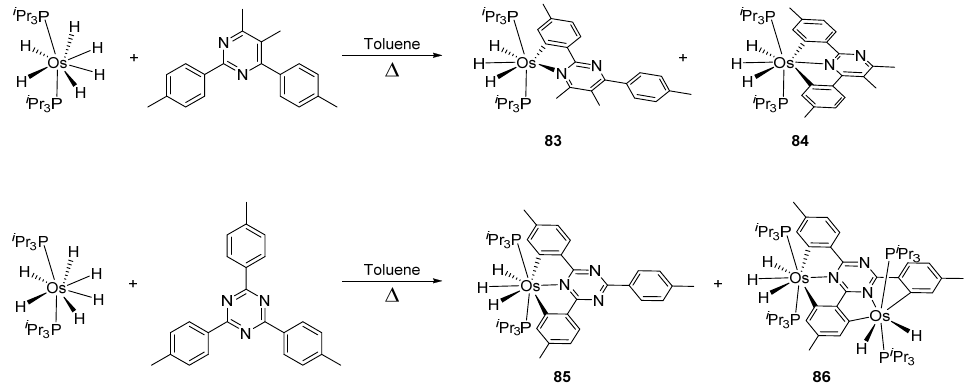
Figure 17. Synthesis of bis -cyclometalated complexes from [OsH 6 (P i Pr 3 ) 2 ].